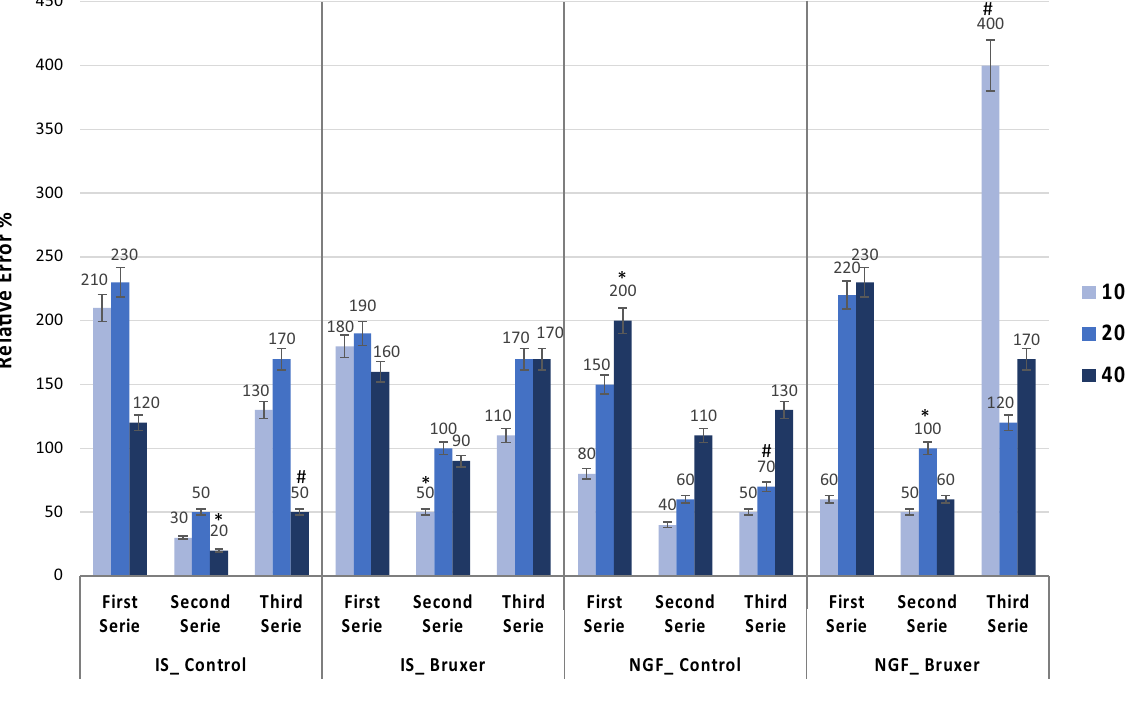
Figure 4. Illustrates the accuracy of the MVC 72 h after the intramuscular administration of either IS or NGF considering differences in the jaw movement performance between actual force values and target force levels at 10, 20, and 40% MVC in the bruxers that received IS or NGF (IS_Bruxer; NGF_Bruxer); and controls that received IS or NGF (IS_Control; NGF_Control). Accuracy is expressed as the relative error (RE) of the actual force level at each force level and series. (*) Indicates significant within-groups and (#) significant between- groups differences at 10%, 20%, and 40% MVC considering first second and third series, and target force level following pairwise post hoc comparisons ( P < 0.01). Tooth clenching task (TCT); maximum voluntary contraction (MVC); nerve growth factor (NGF); isotonic saline